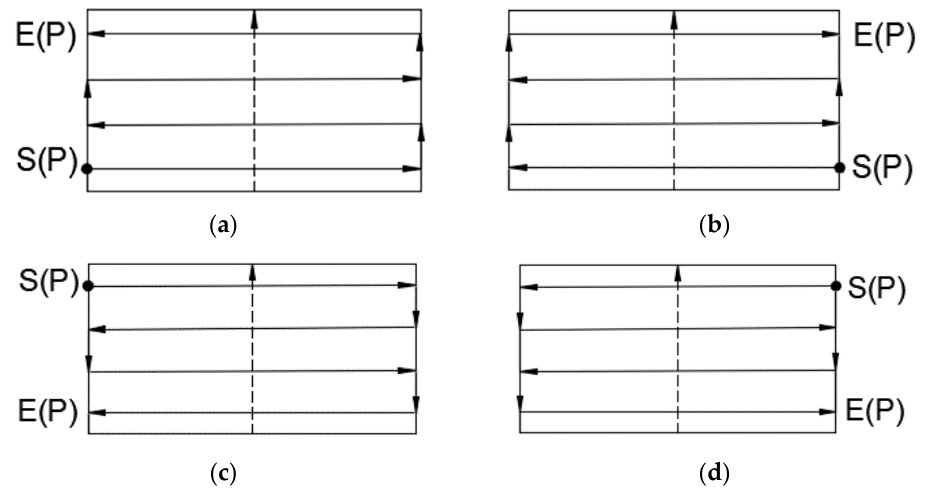
Figure 21. Four different coverage strategies. ( a ) Search direction 1; ( b ) search direction 2; ( c ) search direction 3; ( d ) search direction 4.